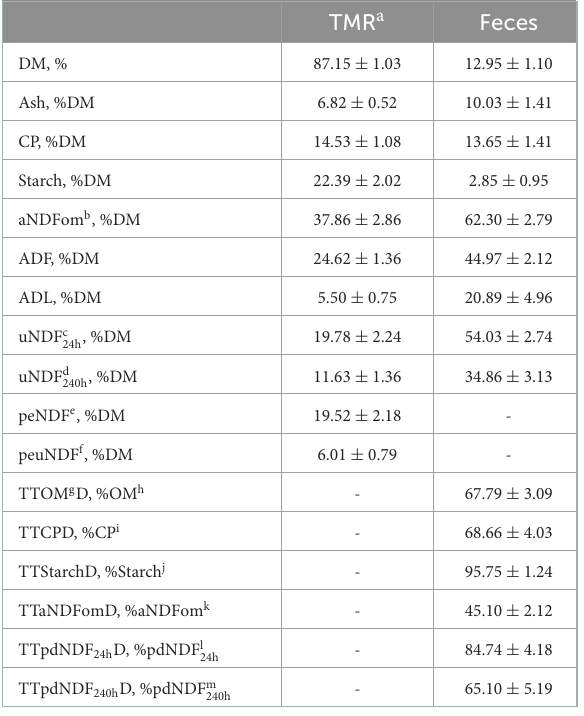
TABLE 1 Composition of TMR diet and feces and apparent total tract digestibility (mean ±